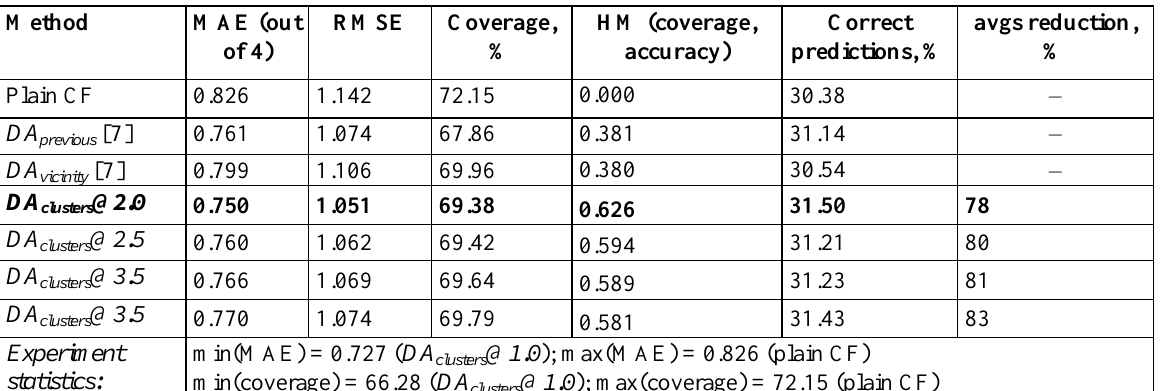
Table 2. Amazon “Videogames” dataset results